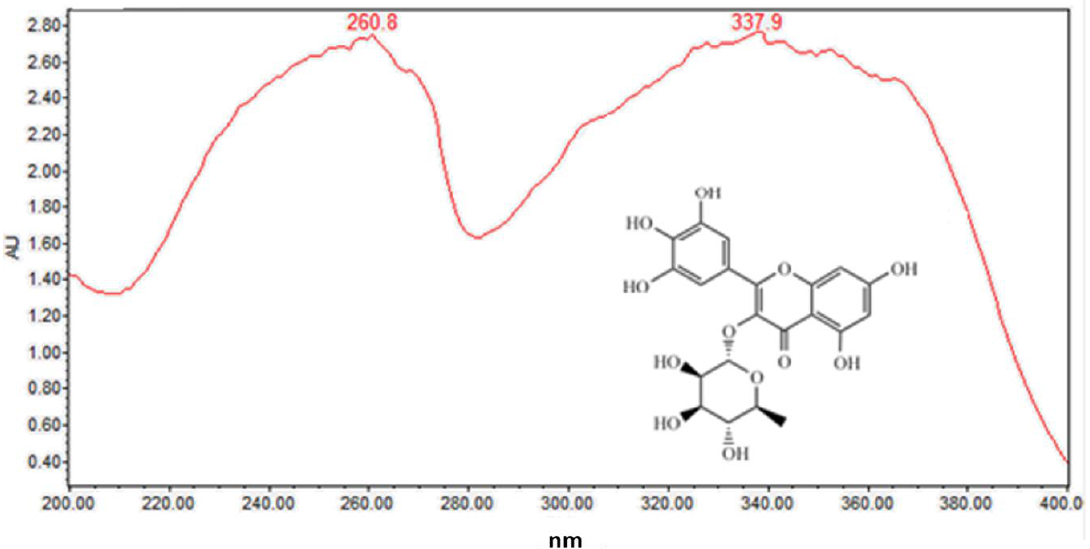
Figure 3. On-line UV-visible spectra of peak 5.